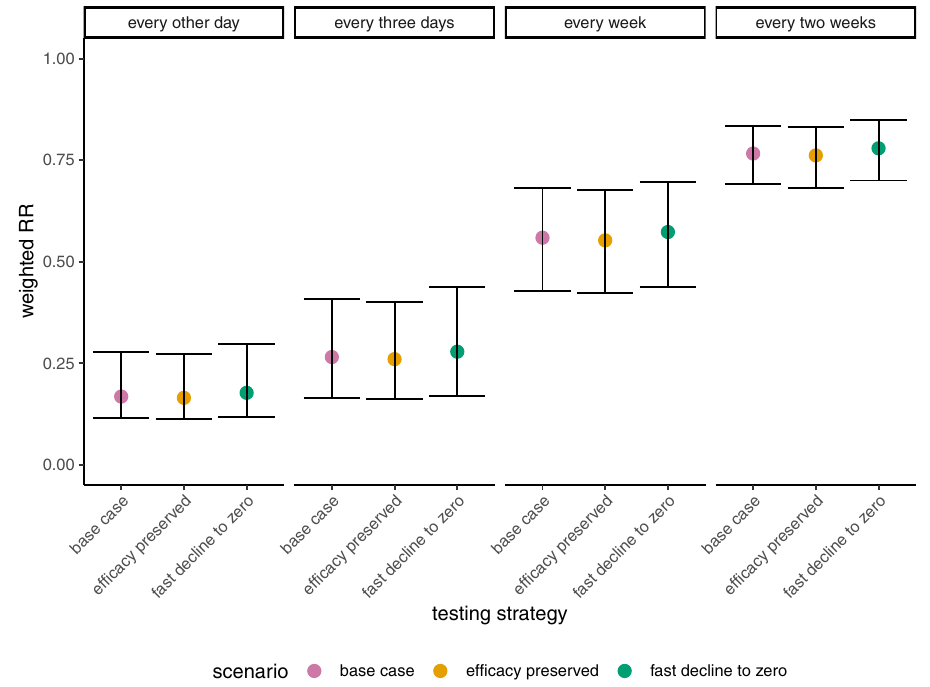
Fig. 3 | Sensitivity of estimated weighted hospitalization risk ratios (weighted RR), relative to the patient population untreated with nirmatrelvir, to treat- ment coverage and treatment delays to assumed treatment ef fi cacy trends, acrosstestingstrategies.TheweightingofRRsre fl ectsthelikelihoodoftesting positive and therefore being treated with nirmatrelvir x days after becoming infected. MedianestimatedweightedRRsofhospitalizationbyassumedtreatment ef fi cacy scenario (base case scenario (pink), scenario with preserved ef fi cacy fol- lowing5daysaftersymptomonset(orange),andscenariowithef fi cacydroppingto